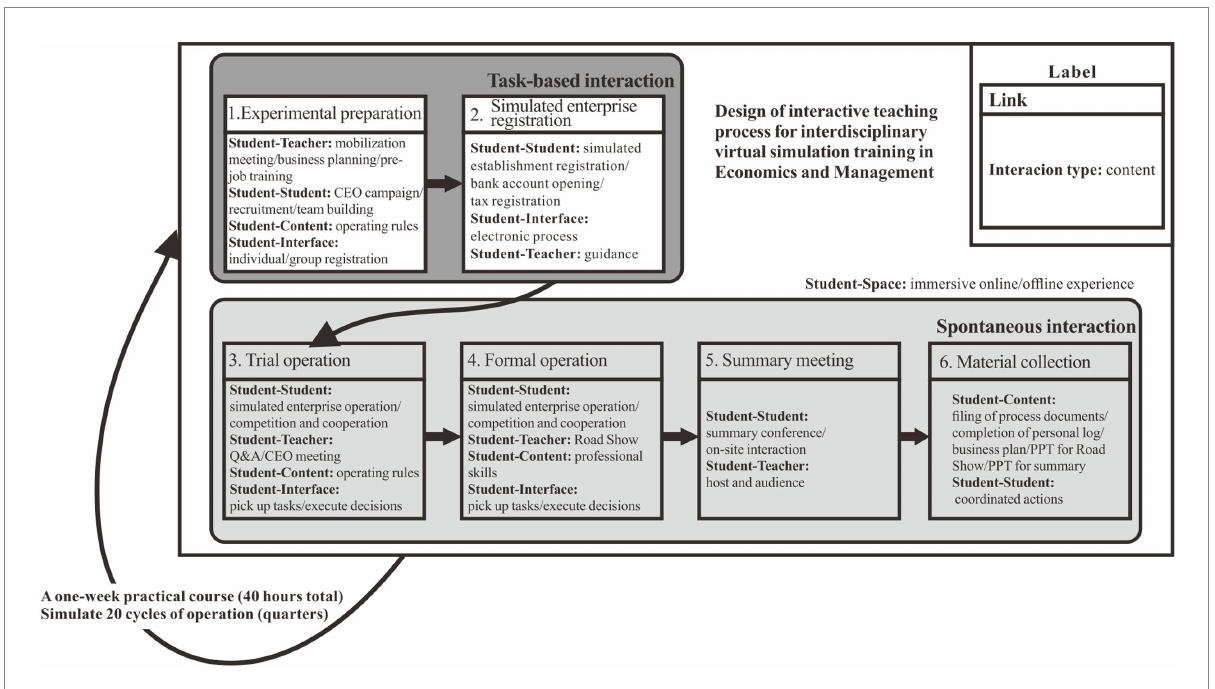
FIGURE 2 Design of interactive teaching process for interdisciplinary virtual simulation training in economics and management.